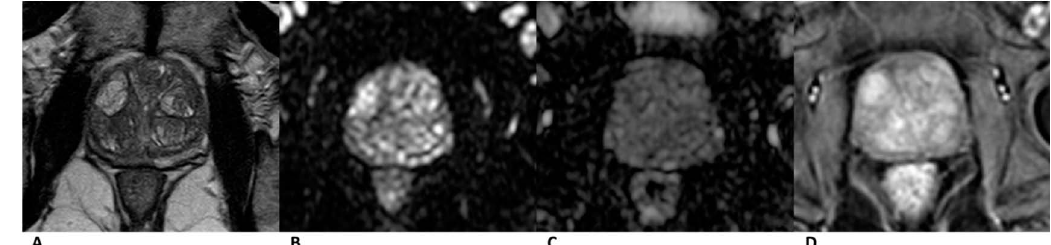
Figure 3. Case of prostate cancer in TZ. Male, 63 years old, prostate cancer with its longest diameter being >1.5cm. T2WI showed a hypointense nodule (arrow) in the right TZ ( A ). The lesion was hyperintense on DWI (b = 1500 s/mm 2 ) (arrow) and hypointense on ADC images ( B , C ). Positive enhancement was seen on the DCE (arrow) ( D ). The lesion was finally assessed as a PI-RADS category 5, indicating that it had a high cancer risk according to PI-RADS v2, PA PI-RADS v2, and biparametric MRI protocols.